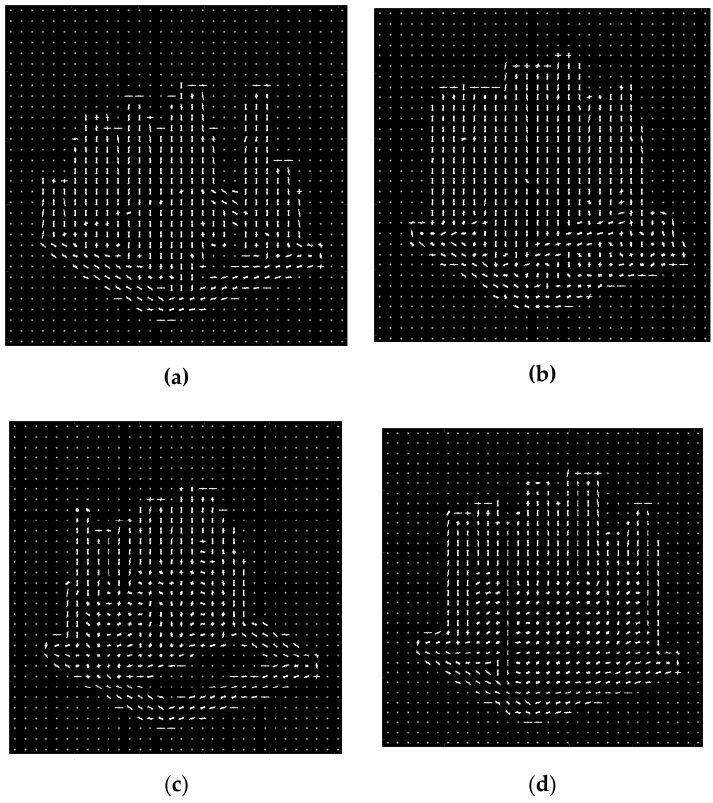
Figure 6. Global visualization of the histogram of oriented gradient (HOG) feature extracted from a 3D PRPS graph: ( a ) result of free metal particles defect; ( b ) result of suspended electrode defect; ( c ) result of metal tip defect; ( d ) result of air gap defect.